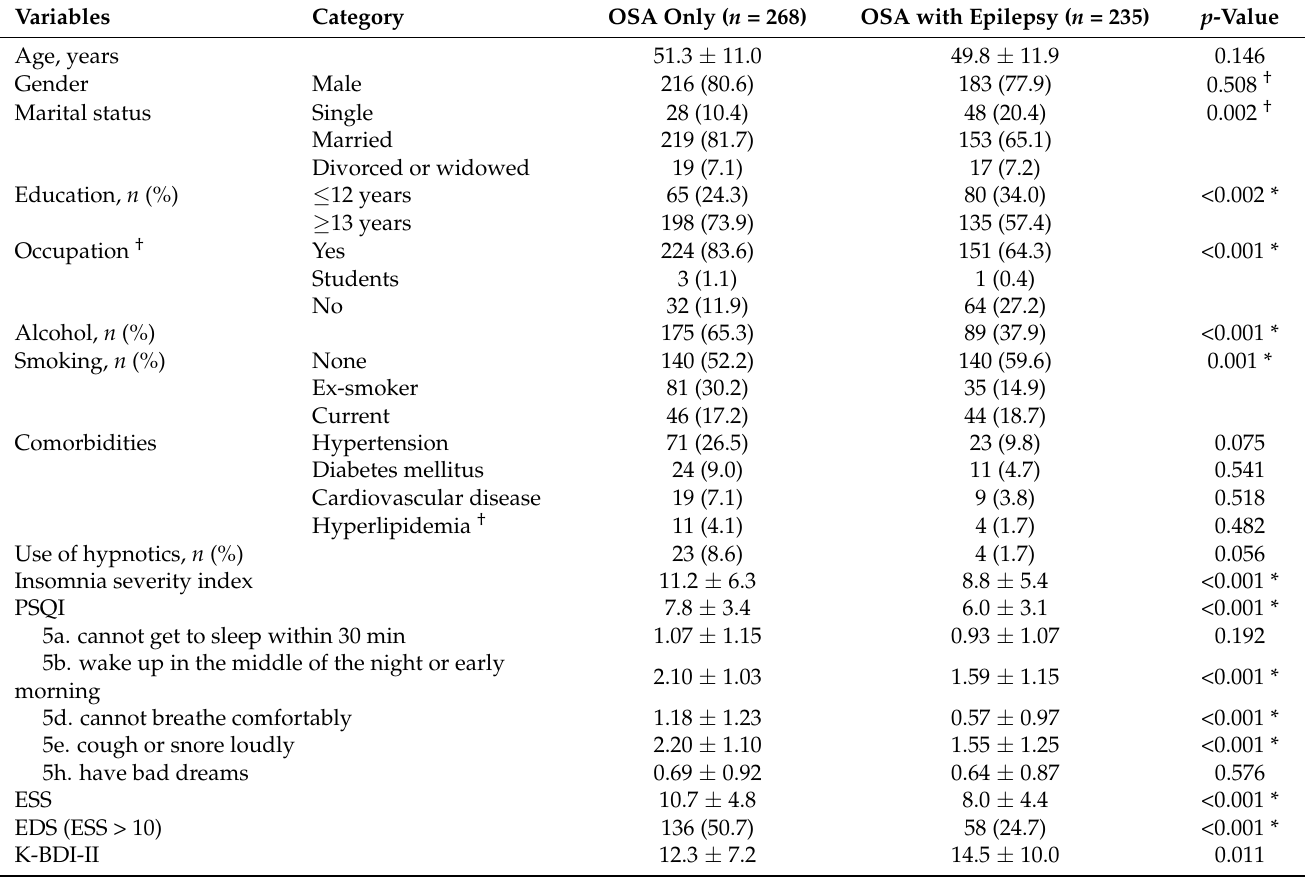
Table 1. Demographics and subjective sleep data.